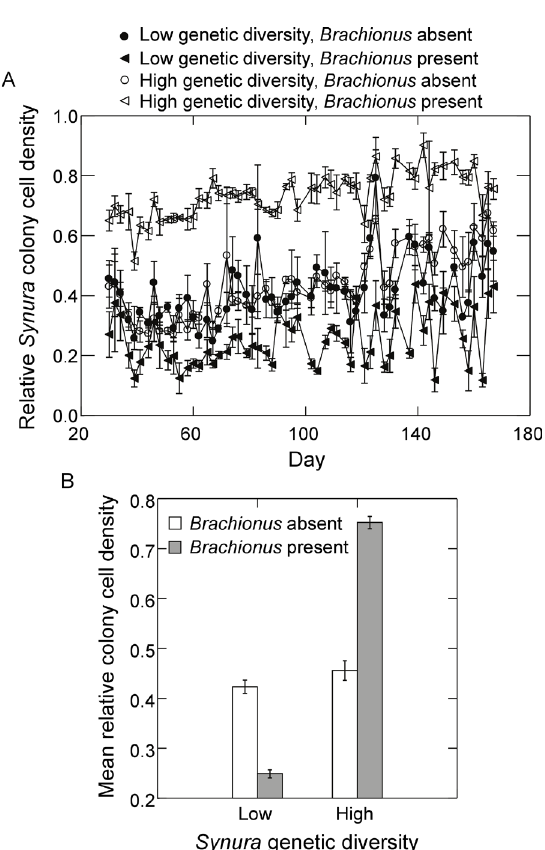
Figure 9. Effects of initial Synura genetic diversity (low versus high) and Brachionus presence/absence on ( A ) the relative abundance of Synura cells found in colonies over time (shown are means across replicates, +/-S.E.), and ( B ) the relative abundance of Synura cells found in colonies averaged over days 51 to 167 (means, +/-S.E.). Relative colony cell density was calculated by dividing the number of cells found in colonies (per mL) by the total cell density per mL (colony cells plus free-living cells).